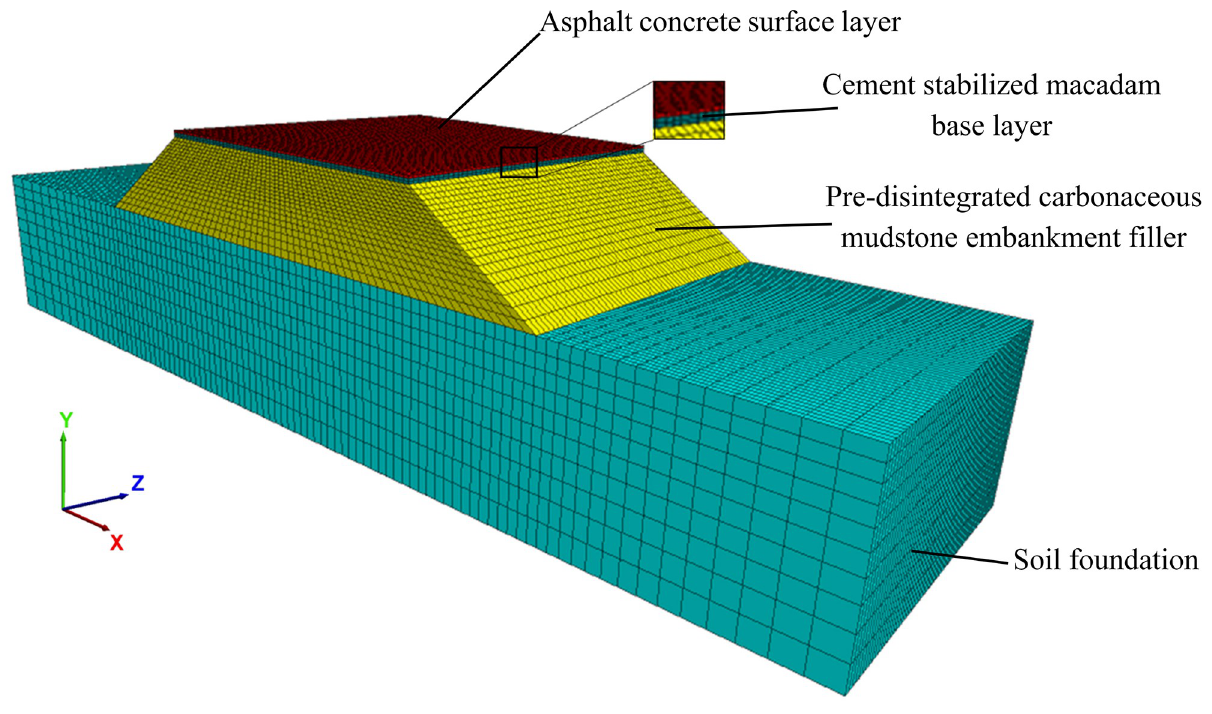
Fig 1. Pavement structure model diagram.